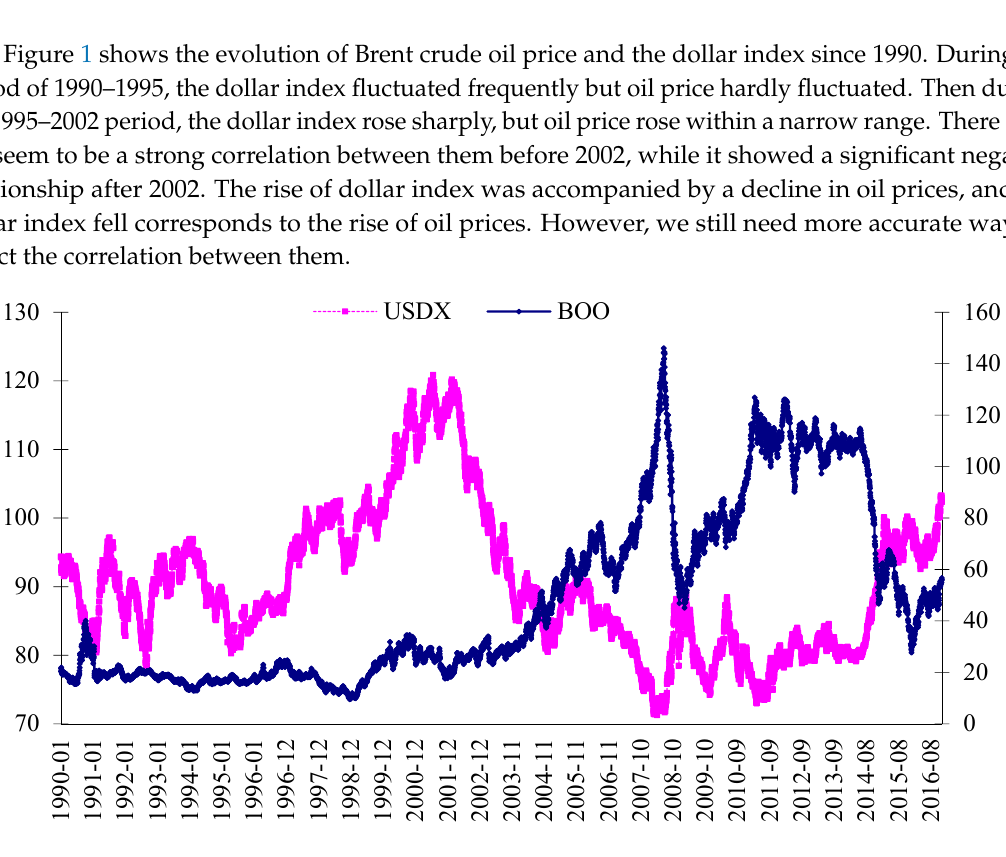
Figure 1. Movement of Brent crude oil prices and the US dollar index. Source: Wind Info, left axis for US dollar index, and the right axis for Brent crude oil price.